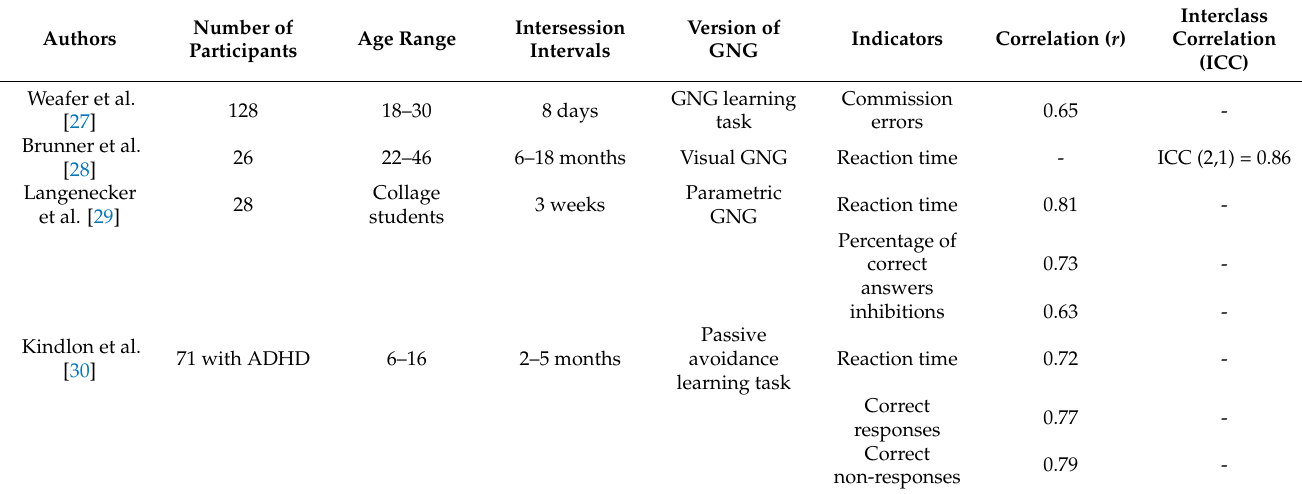
Table 2. Survey on studies for test-retest reliability for Go/No Go